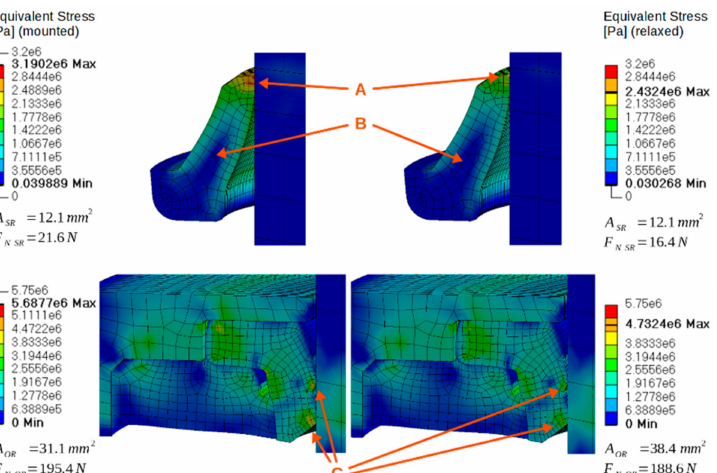
Figure 8. Comparison of the equivalent stress distribution of the rod guide assembly/rod FEM setup, divided into the scraper/rod contact (top) and the oil seal/rod contact (bottom) before (left) and after (right) material relaxation time, with the resulting contact areas A SR and A OR and the circumferential scraper/rod and oil seal/rod contact normal forces F NSR and F N OR